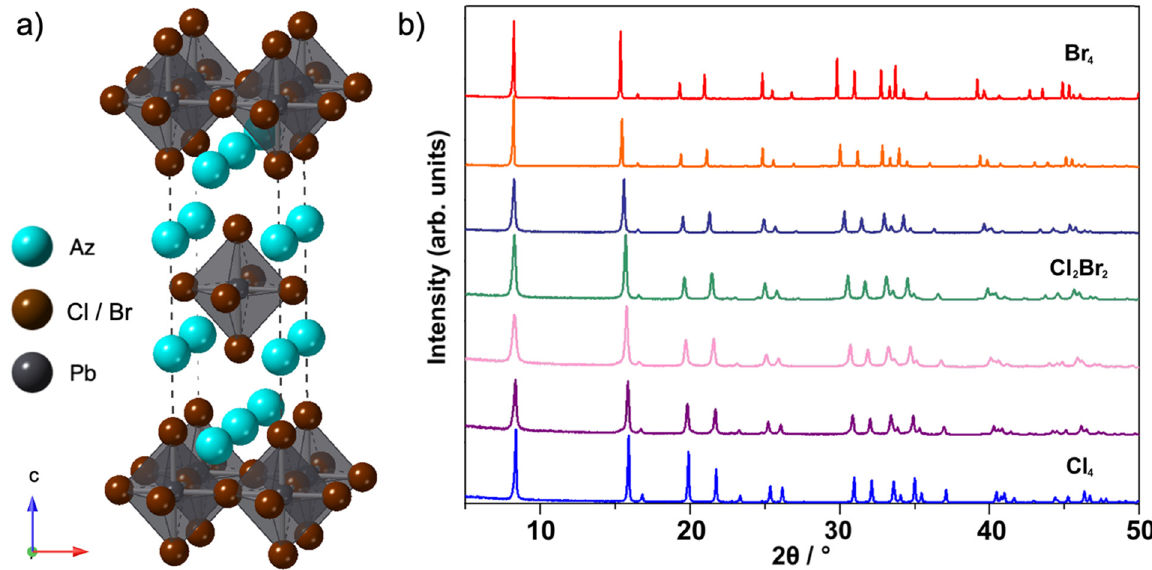
Figure 1. ( a ) n = 1 Ruddlesden–Popper (R–P) phase of Az 2 PbX 4 (X = Cl, Br) showing alternating AzPbX 3 perovskite and AzX rock salt layers along the c -axis, ( b ) PXRD data of mix-halide layered R–P phases: Az 2 PbCl x Br 4 − x with composition 0 ≤ x ≤ 4 prepared by mechanosynthesis.